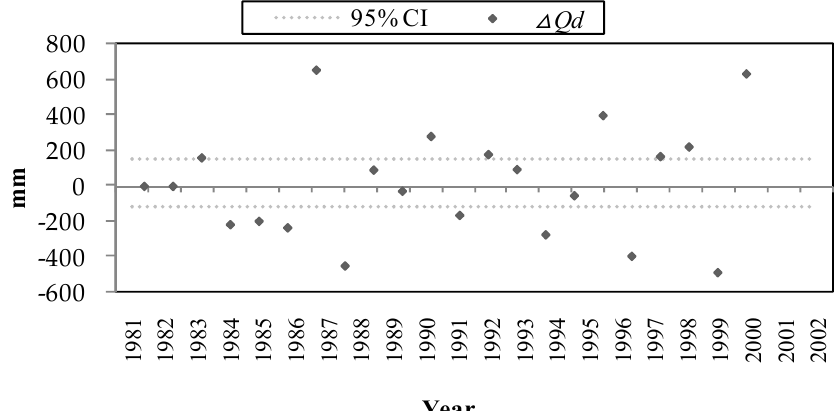
Figure 4. An example of 95% CI. Note: ∆ Q d located beyond 95% CI are viewed as data points affected by both of the other factors and statistical errors, while ∆ Q d within 95% CI are viewed as data points with statistical errors. CI: confidence interval.